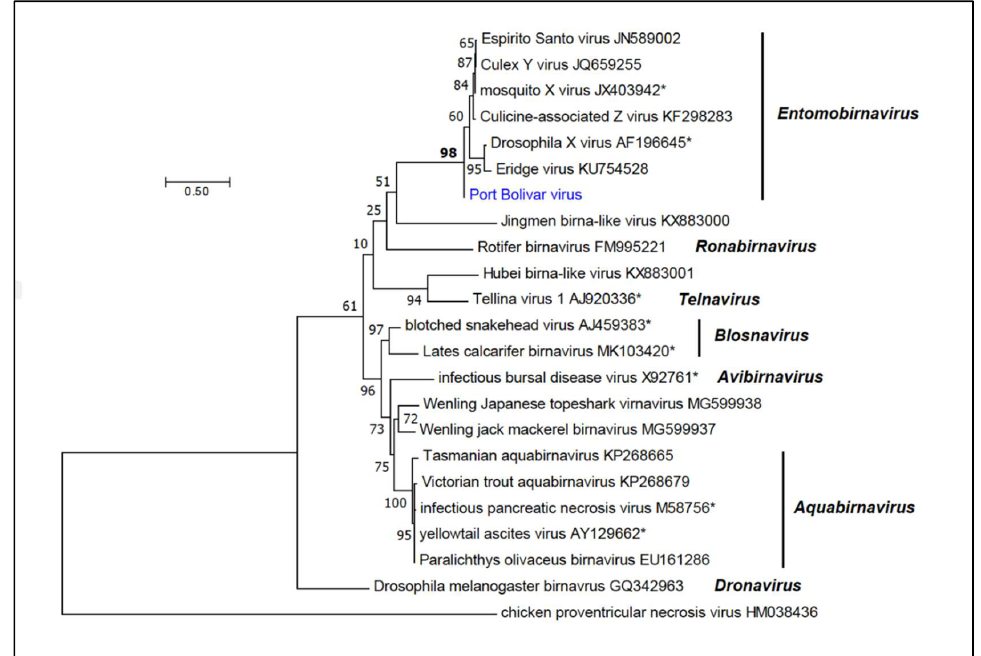
Figure 4. Phylogenetic relationships of Port Bolivar virus. An unrooted phylogenetic tree was inferred by using the Maximum Likelihood method from a ClustalW alignment of complete VP1 protein (RdRp) amino acid sequences of Port Bolivar virus (PTBV) and 22 birnaviruses. Phylogenetically informative sites were selected from the alignment using Gblocks, resulting in 274 positions in the final dataset. The tree with the highest log likelihood ( − 6338.33) is shown. The tree was drawn to scale, with branch lengths measured in the number of substitutions per site. Bootstrap values (100 iterations) are shown for each node. All seven established genera are shown in bold italics; those viruses which have currently been assigned to species are also shown.